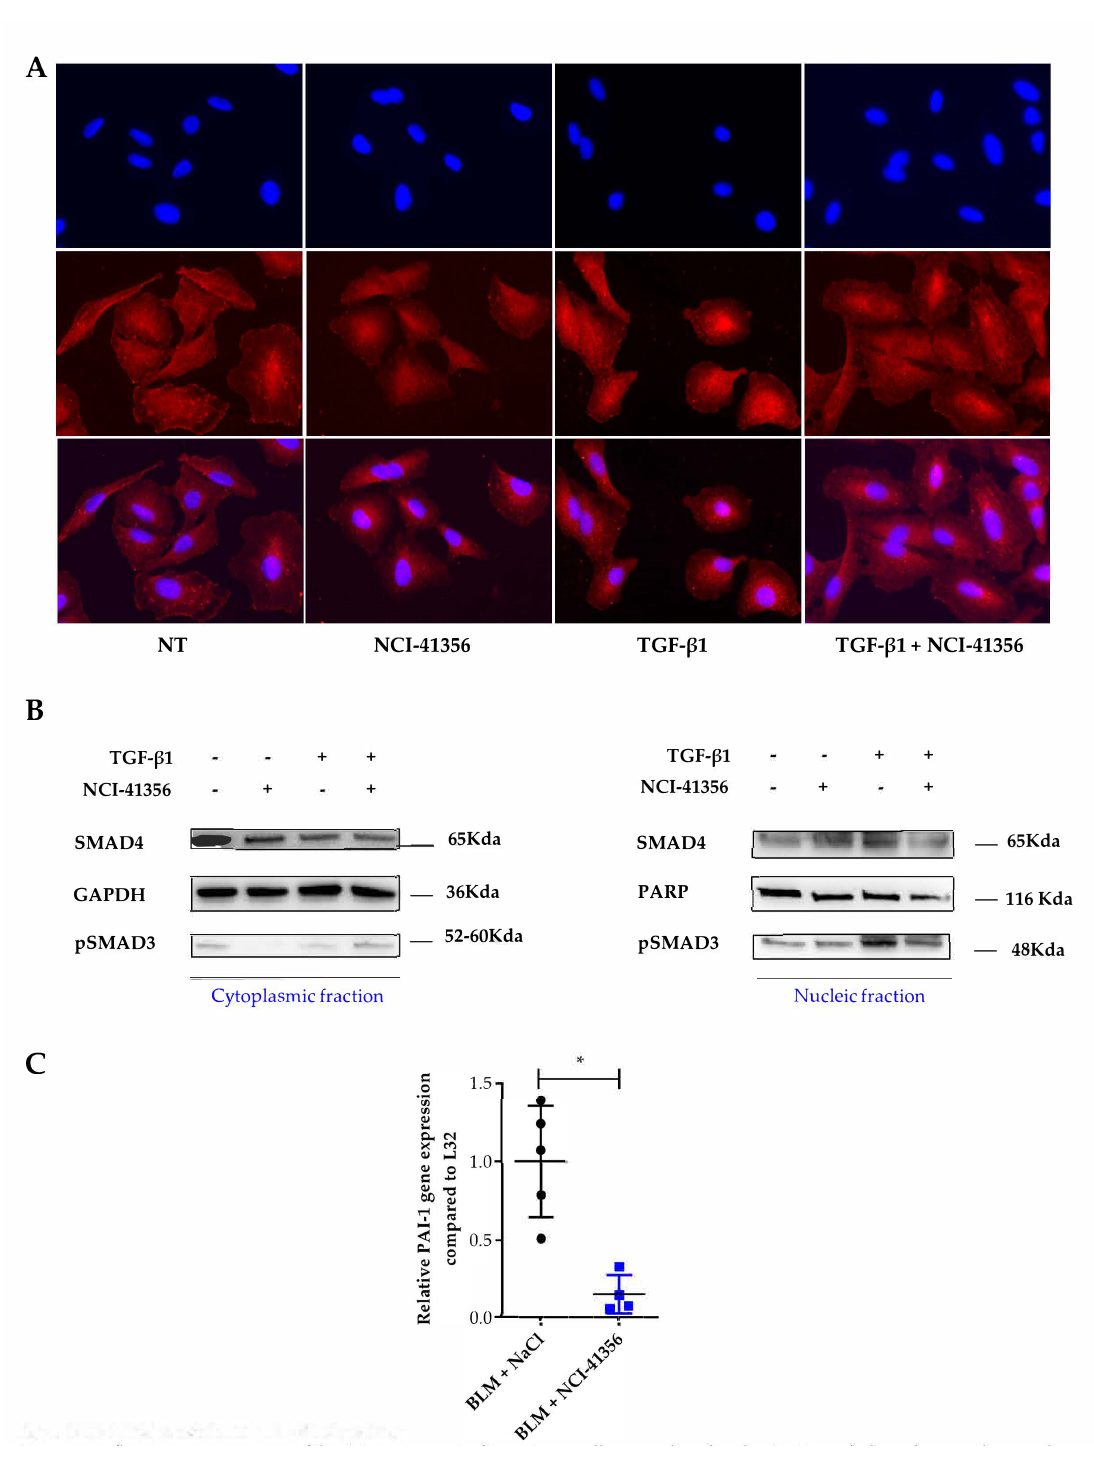
Figure 4. NCI-41356 modulates TGF- β 1 signaling. ( A ). Immunofluorescence staining of SMAD4 protein (red) on A549 cells treated with TGF- β 1 (10 ng/mL) with or without NCI-41356 (100 µ M) ( n = 3) ( × 40). Nuclear staining: 4 (cid:48) ,6-diamidino-2-phenylindole (blue); ( B ). Protein expression os Smad4, pSMAD3, GAPDH and PARP studied by Western blot of nuclear or cytoplasmic fractions of A549 cells treated with TGF- β 1 (10 ng/mL) with or without NCI-41356 (100 µ M). One representative experiment out of three is shown; ( C ). Relative PAI-1 mRNA expression compared to control L32 in the lung of mice treated by bleomycin with or without NCI-41356 by intravenous route (* p = 0.0159). Data are expressed as means ± SEM and compared using nonparametric Mann–Whitney